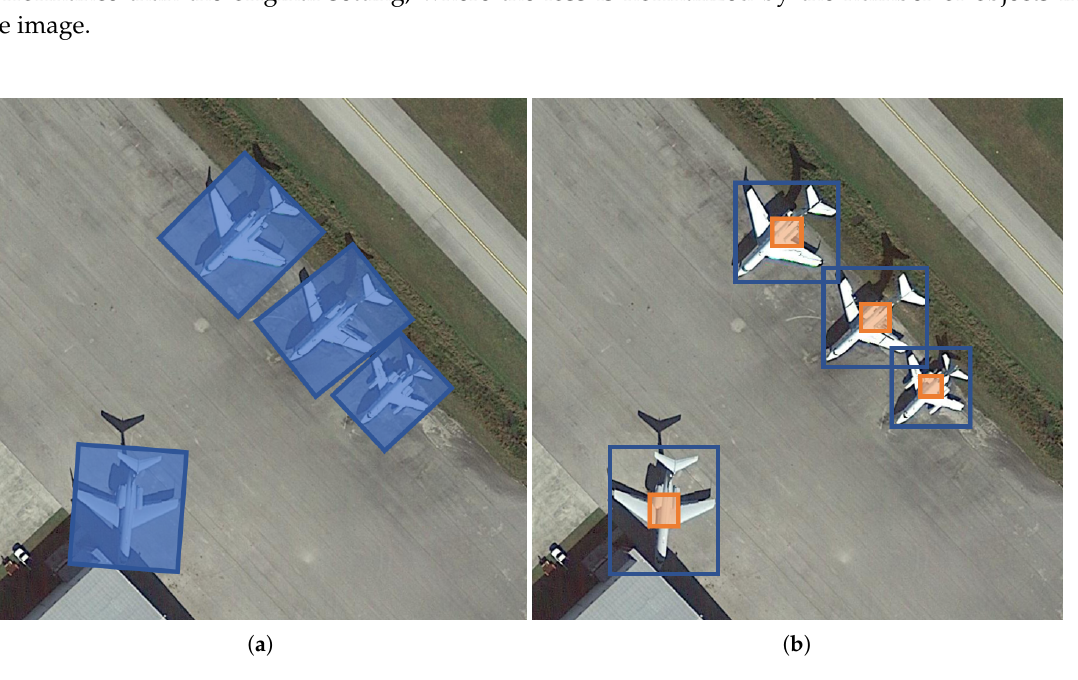
Figure 5. The labeling methods of ( a ) the previous attention methods and ( b ) the proposed CPM. The foreground pixels are denoted by blue and orange, respectively. For the proposed CPM, the range of the foreground pixels is defined by the 1 of the horizontal bounding s